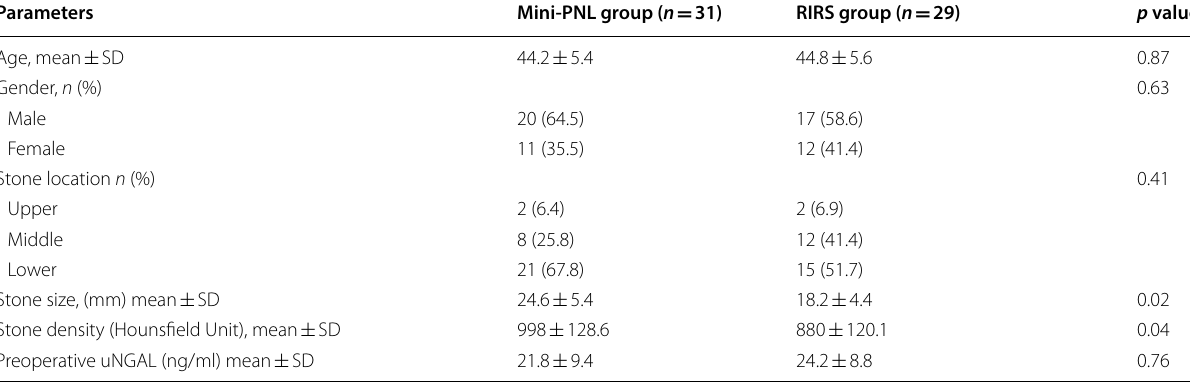
Table 1 Comparison of the two groups for the demographic and baseline characteristics